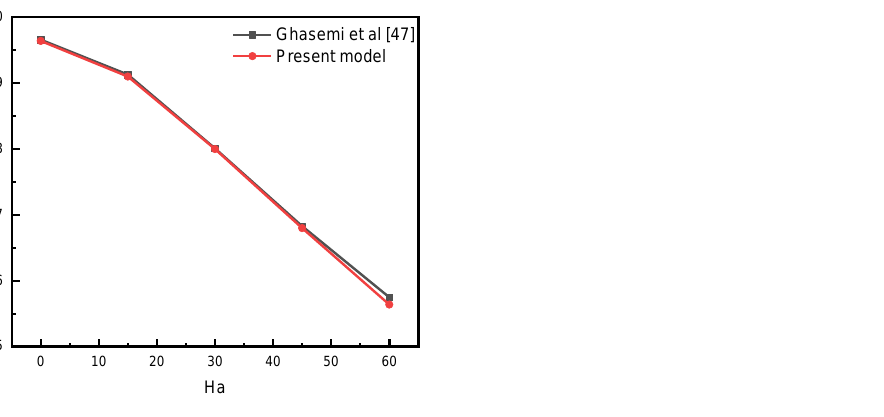
Figure 2. Comparisons of the present model with previous works [47]. Reproduced with permission from [47]. Elsevier, 2022.